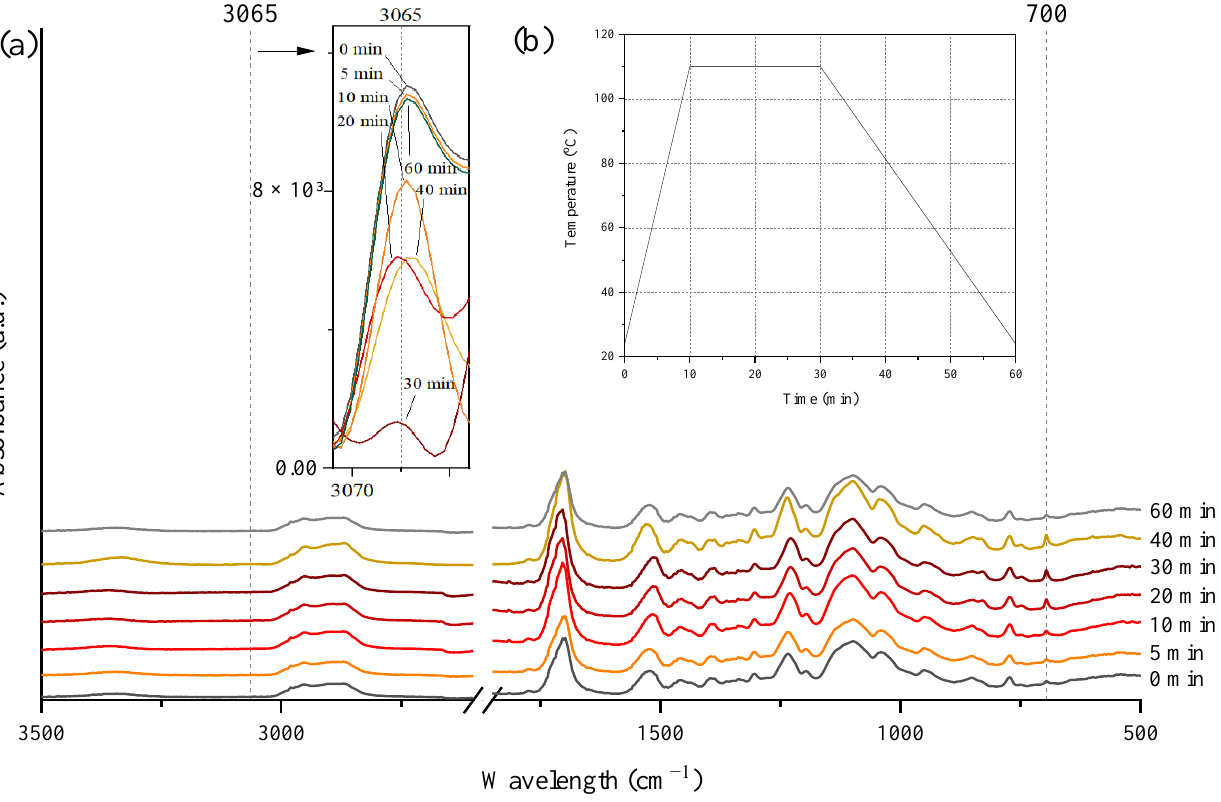
Figure 9. FTIR spectra of the UV-cured UA-DA film during a heating – thermostatic – cooling cycle (on the example of sample UA-DA-HEA at 110 °C) – ( a ); and the temperature program during the test ( b ).